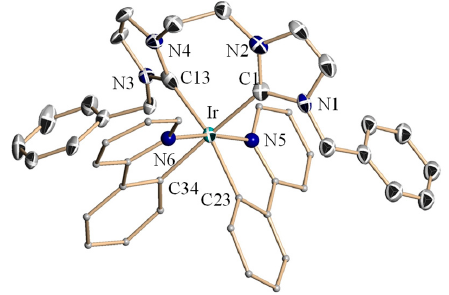
Figure 5. Molecule structure of 4e in the solid state. Only one of two cations presented in the asymmetric unit is shown. Hydrogen atoms, anions, disordered ether molecules and a disorder of one benzyl substituent are omitted and ppy ligands are simplified for clarity. Selected distances [Å] and angles [°]: Ir-C1 2.087(10), Ir-C13 2.161(9), Ir-C23 2.049(8), Ir-C34 2.043(9), Ir-N5 2.041(7), Ir-